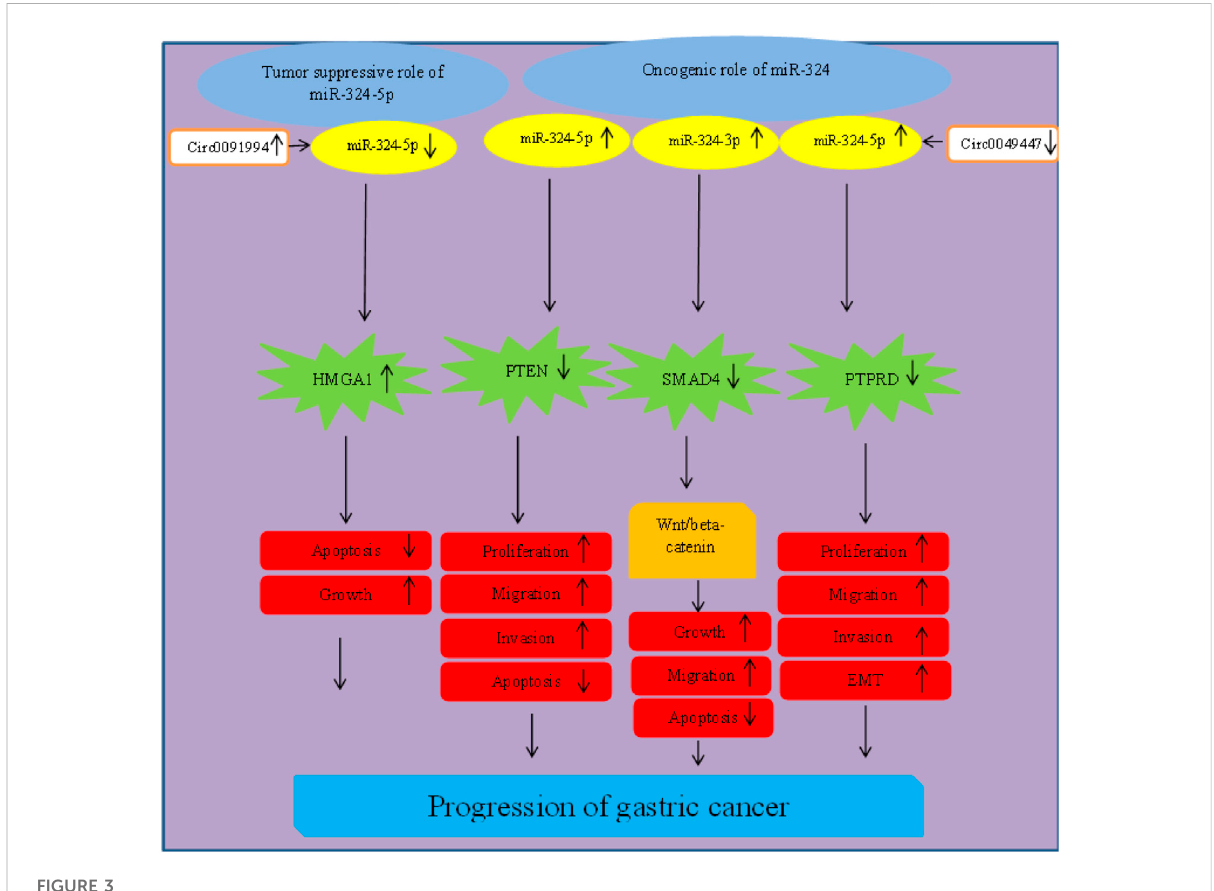
FIGURE 3 Role of miR-324 in progression of gastric